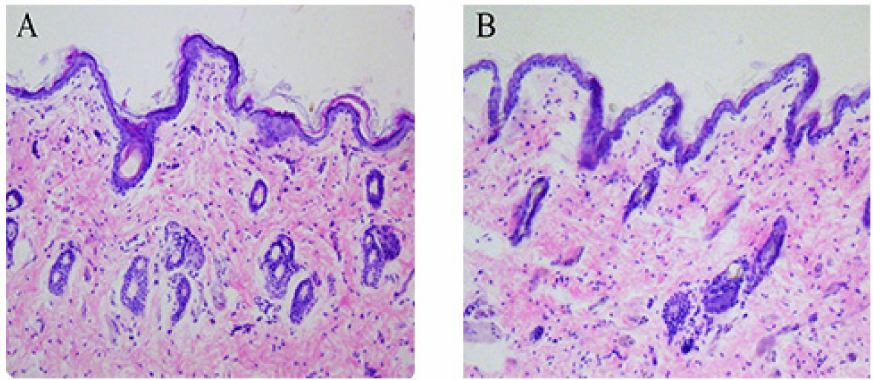
Figure 8. Skin cross-sections after staining with hematoxylin-eosin and examination under light microscope. ( A ): Control with no treatment, ( B ): PAE ethosomes.